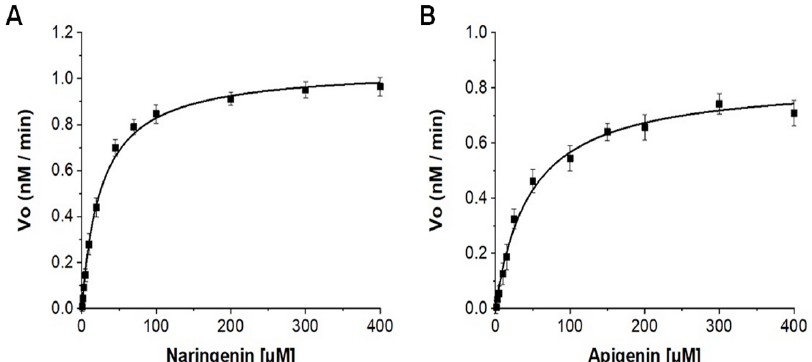
Figure 3. Determination of the kinetic parameters of naringenin and apigenin catalyzed by CYP101D5. The overall kinetic parameters were determined using CYP:Pdx:PdR at a ratio of 1:8:2. Hyperbolic fits of the hydroxylated products of naringenin ( A ) and apigenin ( B ) are shown. The bars on each point represent the standard deviation of the individual experiments.